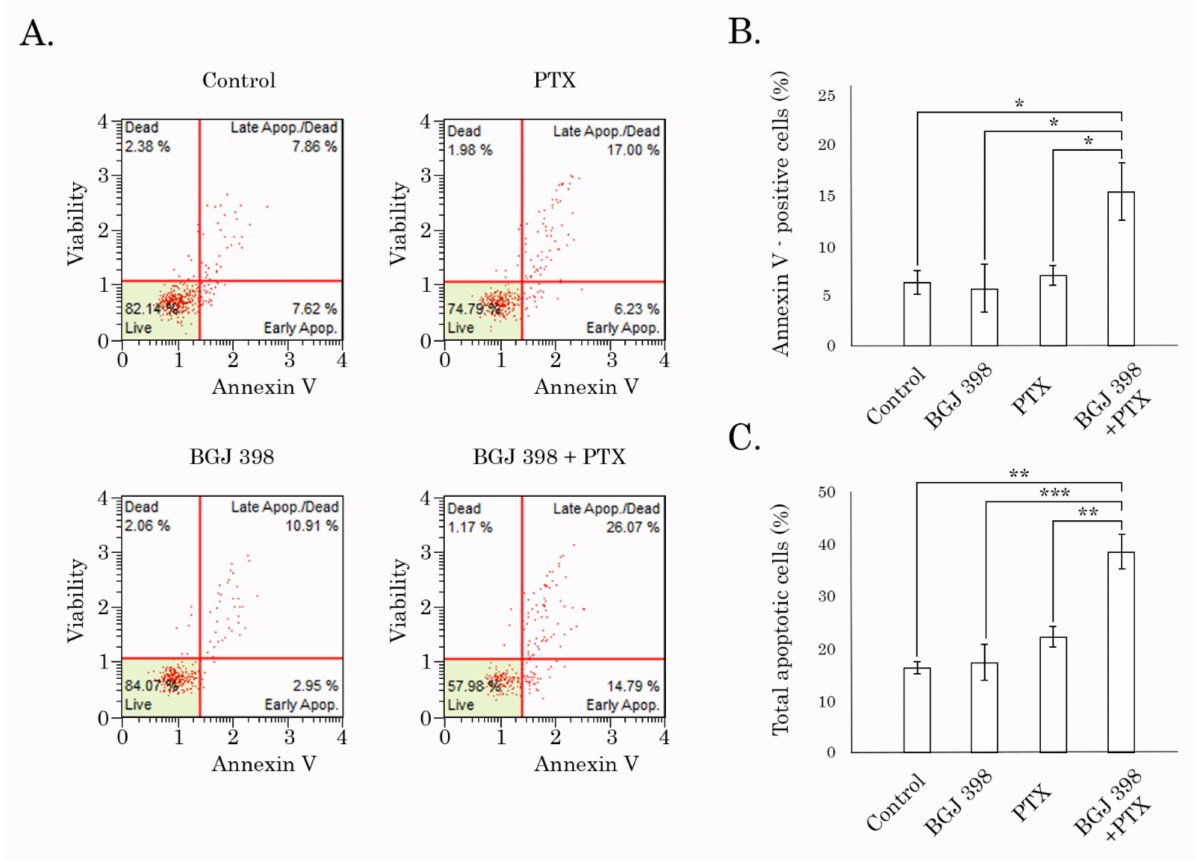
Figure 7. FACs analysis for apoptotic markers in Tx-R HCC 1806 breast cancer cells treated with DMSO (negative control), PTX (1 µ M), BGJ 398 (1 µ M) alone or in combination for 48 h. ( A ) Represen- tative dot-plot are shown. ( B ) Quantitative analysis of the early apoptotic cells after the treatment as indicated above. ( C ) Quantitative analysis of the total apoptotic cells after the treatment as indicated above. * p < 0.05, ** p < 0.01, *** p <